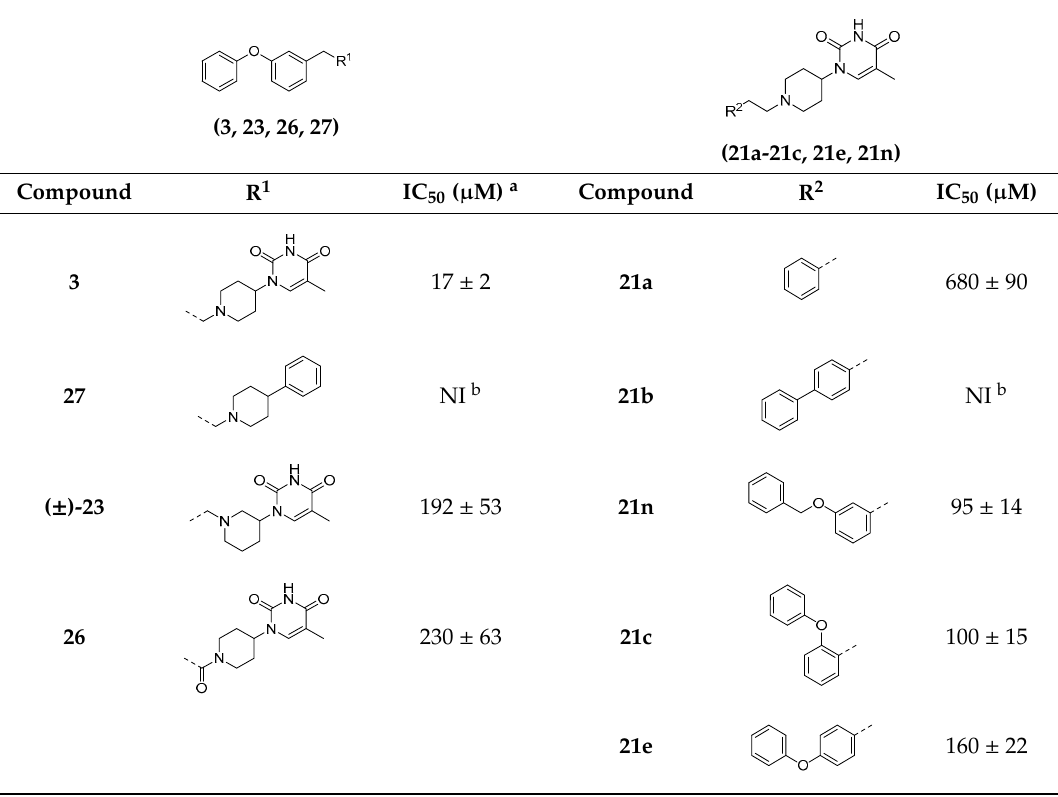
Molecules 2020 , 25 ,